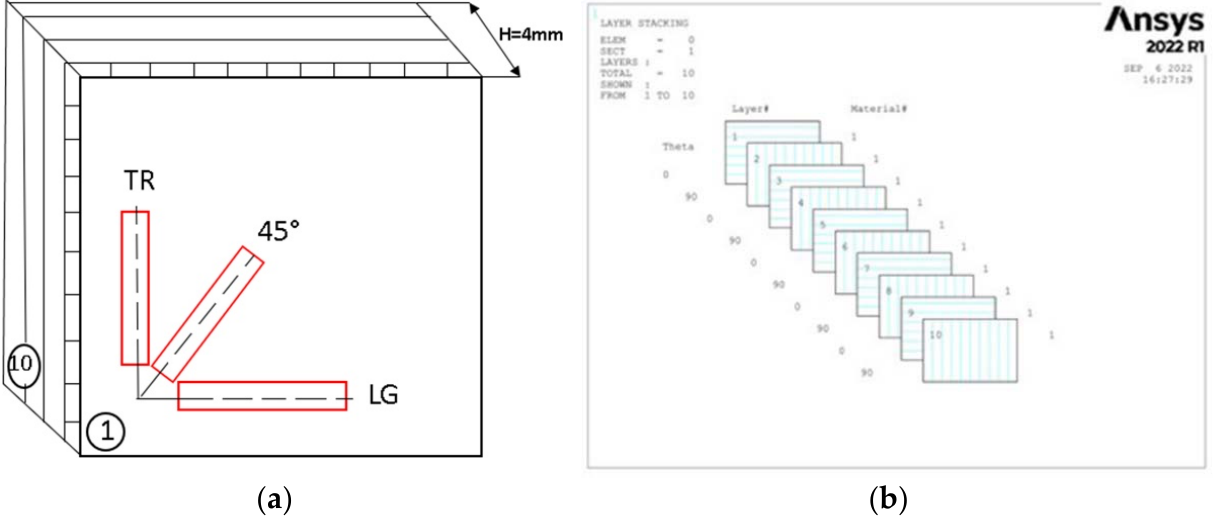
Figure 2. ( a ) Directions for sampling from the GFRP plate (emphasized with red frame) ( b ) and configuration of layers composite (0°/90°).